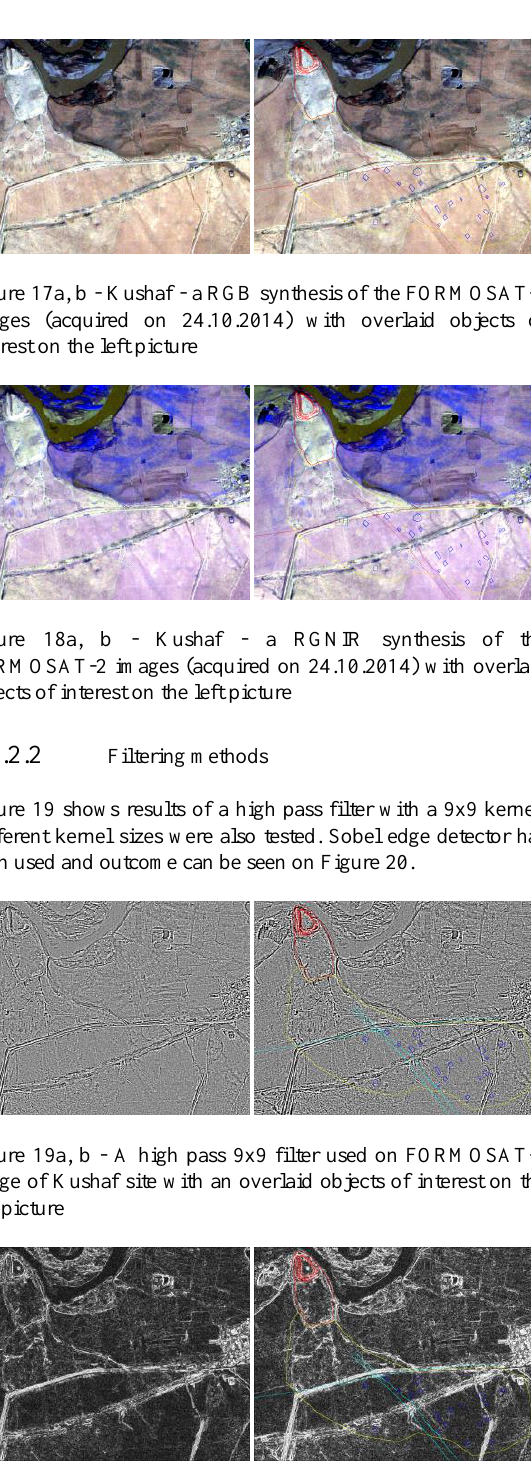
Figure 20a, b - A Sobel edge detector used on FORMOSAT-2 image of Kushaf site with an overlaid objects of interest on the left